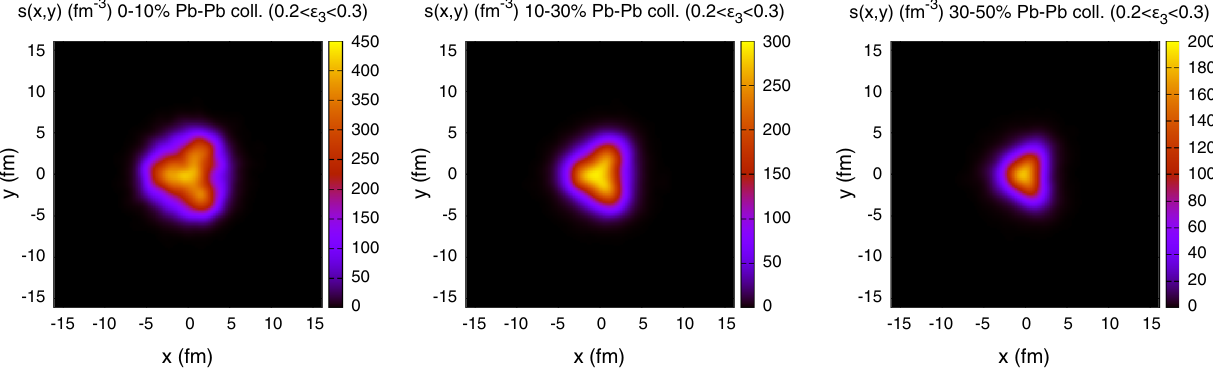
√ s NN = 5 . 02 TeV of fixed triangular eccentricity 0 . 2 ≤ (cid:7) 3 ≤ 0 . 3 and different centrality